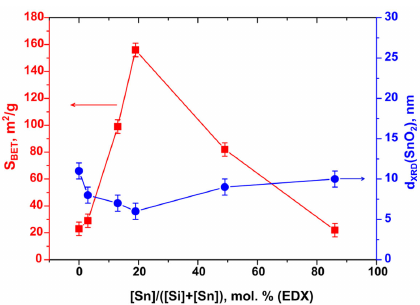
Figure 4. Specific surface area S BET and SnO 2 crystallite size d XRD depending on silicon content in SnO 2 /SiO 2 nanocomposites annealed at 600 ◦ C.